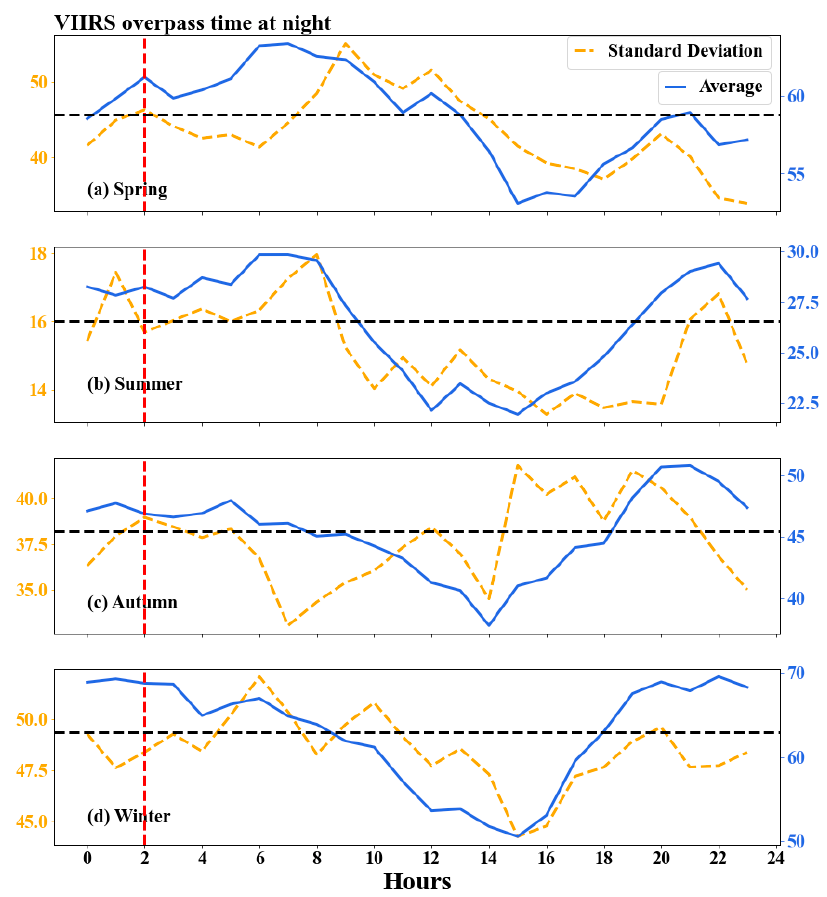
Figure 12. Hourly seasonal average of PM 2.5 concentration at the Shijiazhuang site (longitude: 114.5481°, latitude: 38.0378°) in Beijing Time. The orange dotted line represents the hourly standard deviation of the seasonal average. The blue solid line represents the hourly PM 2.5 concentration of the seasonal average. The red dotted line represents the PM 2.5 concentration at the time of the VIIRS overpass, while the black dotted line is the seasonal average daily PM 2.5 concentration (right y axis).